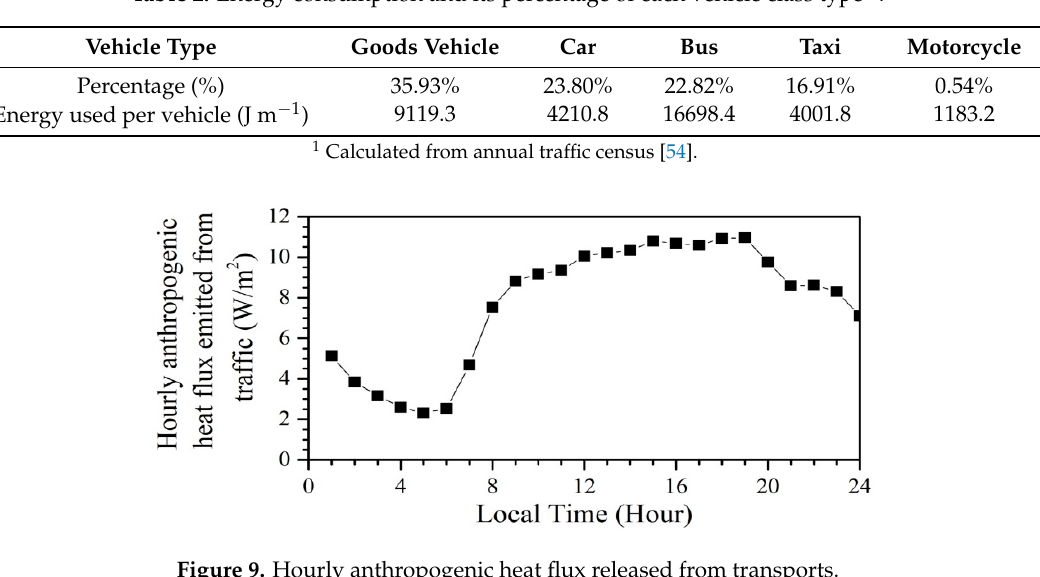
Figure 9. Hourly anthropogenic heat flux released from transports .